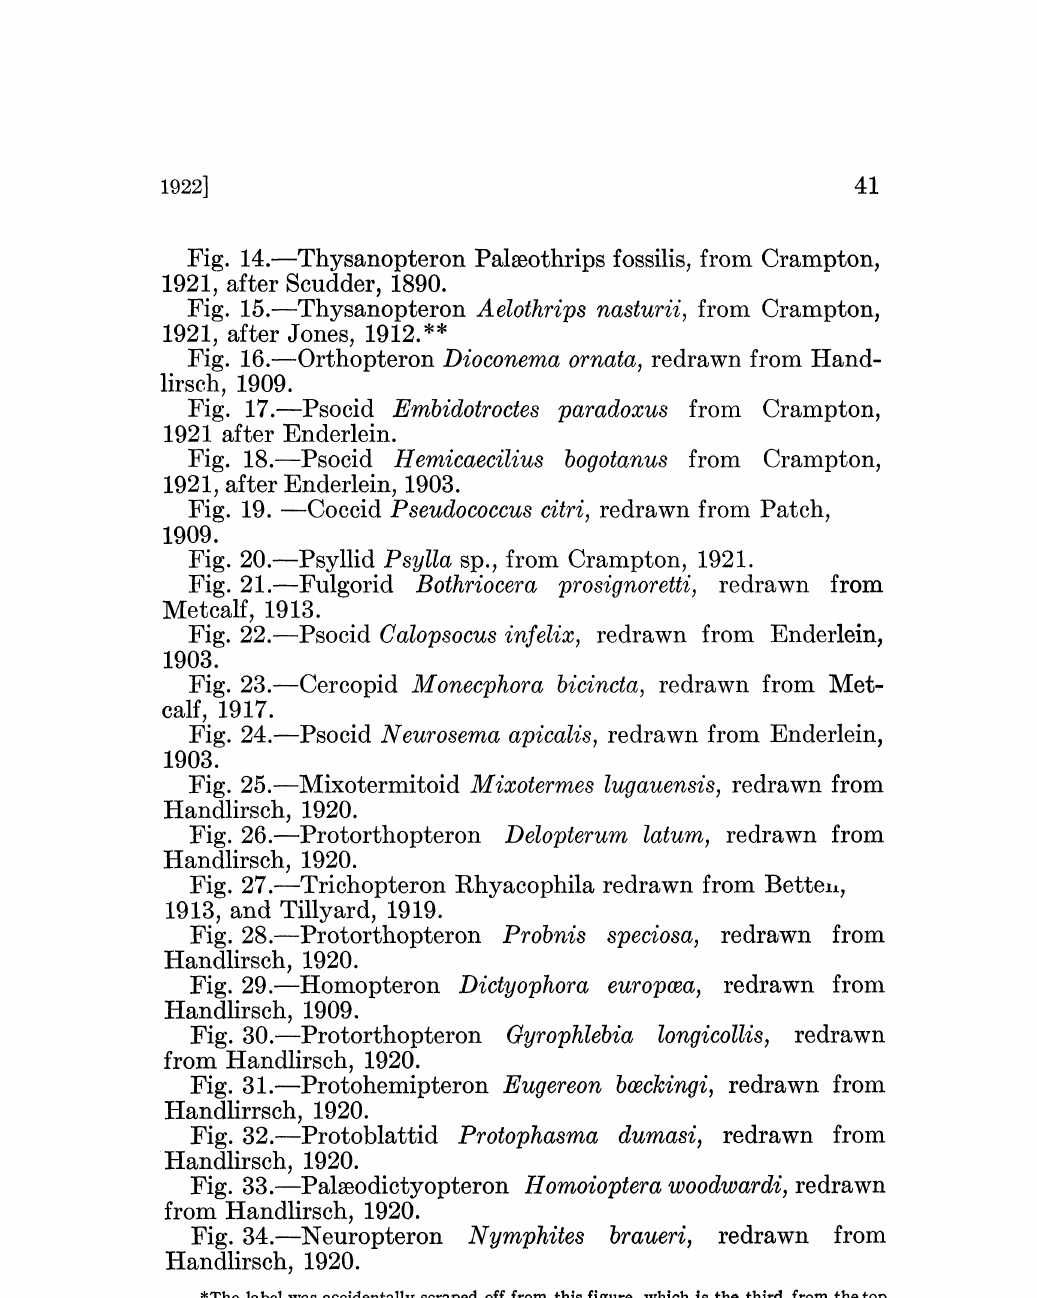
Fig. 34.mNeuropteron Nymphites braueri, redrawn from Handlirsch,